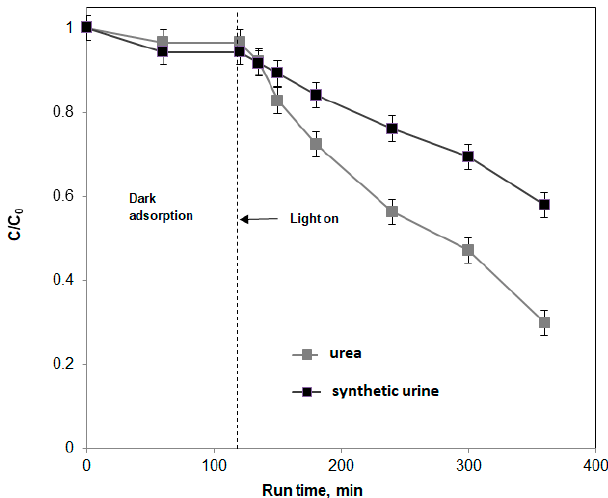
Figure 5. Behavior of urea’s relative concentration as a function of run time in the dark phase and under visible light irradiation obtained using PS-VD LED dimming modulation in the presence of distilled and synthetic urine water. Urea initial concentration: 25 g / L; solution volume: 250 mL; N-TiO 2 / PS amount: 120 g.